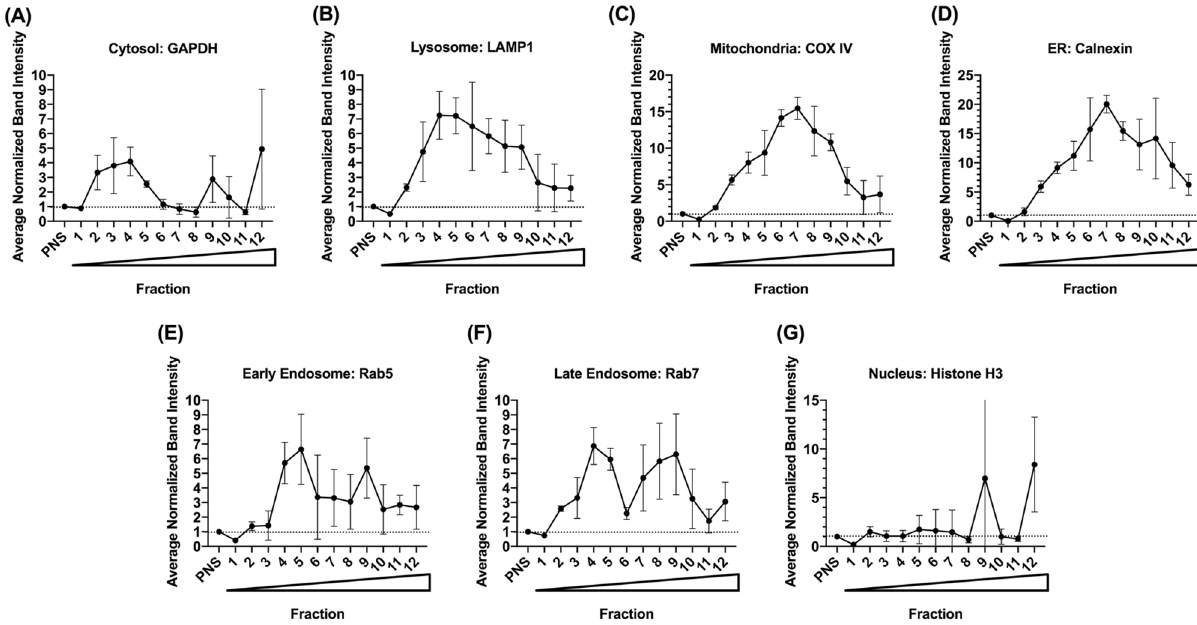
Figure 3. Subcellular organelle marker profiles characterized by immunoblot (normalized by protein amount loaded). All band intensities were normalized to per µg protein loaded, and each fraction’s band intensity was normalized to its corresponding PNS band intensity. Circles represent the average normalized band intensity by protein amount from three human liver donors, and error bars stand for the standard deviation. Wedge indicates increasing sucrose % from fraction 1 to